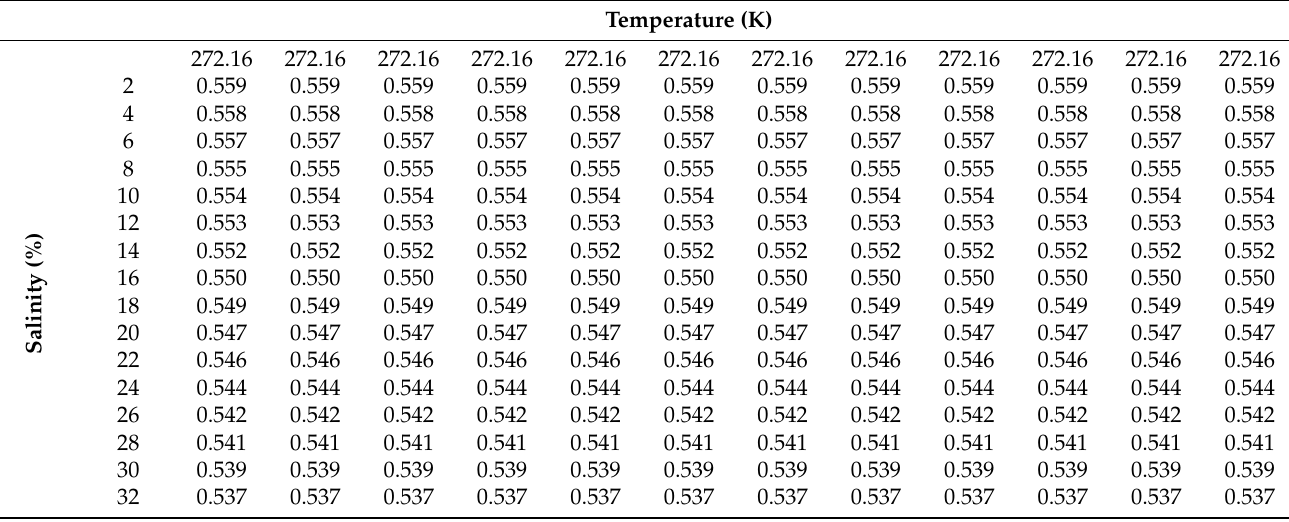
Table A2. Salted water thermal conductivity (W/m